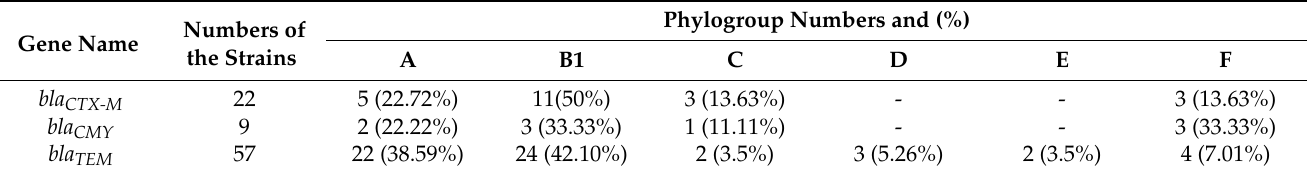
Table 4. Association of B-Lactam resistance genes ( bla CTX-M , bla CMY , bla TEM ) and phylotypes of Escherichia coli isolates illustrated by numbers and